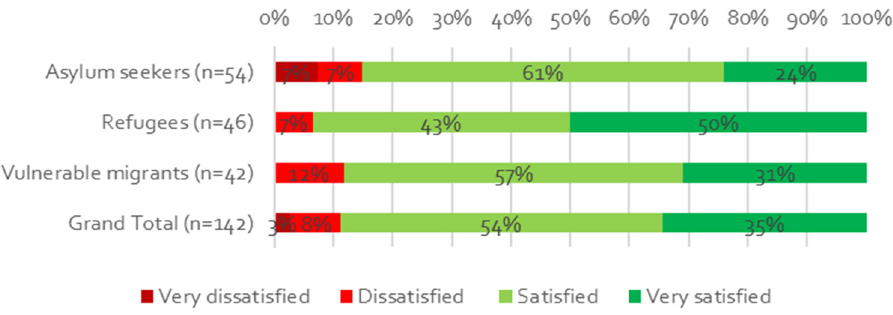
Figure 2. Response to the prompt “Please rate your level of satisfaction with the overall experience of NADINE platform”.